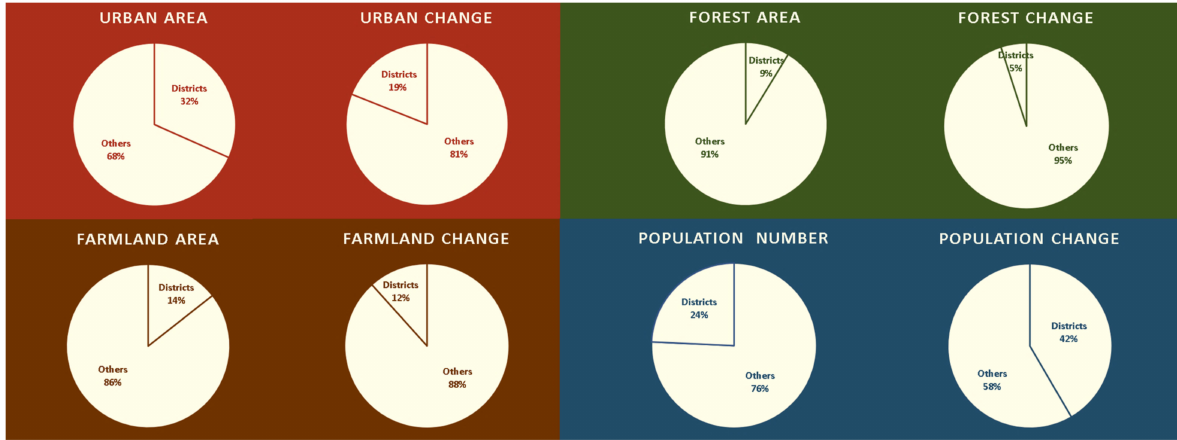
Figure 9. Seven districts’ combined contribution to nation (CN) from 2016 to 2019. It shows that the total area and change of the seven districts’ urban, farmland and forest areas occupied a part of the national